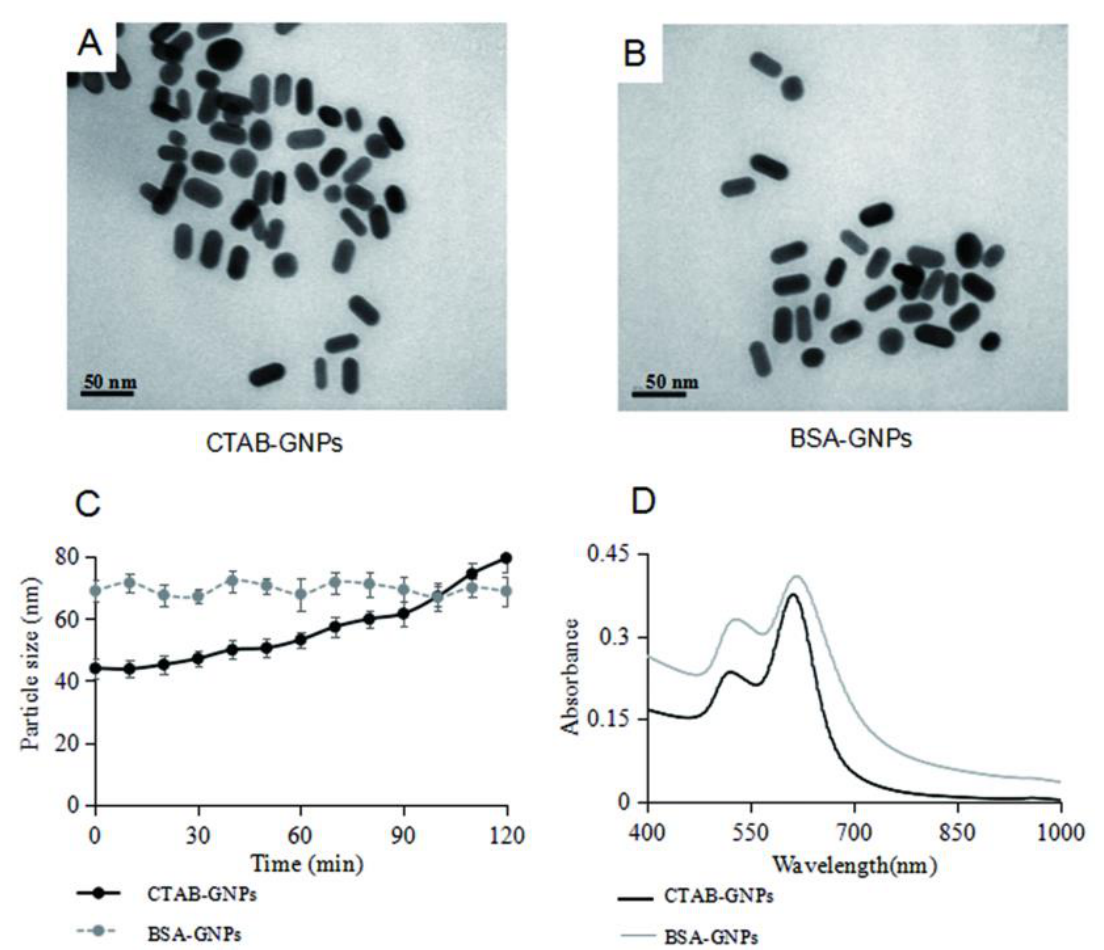
Figure 1. Characterization of GNPs. ( A ) TEM image of CTAB-GNPs in distilled water. ( B ) TEM image of BSA-GNPs in distilled water. ( C ) Hydrodynamic size of GNPs in DMEM. ( D ) UV-vis spectra of GNPs in distilled water.